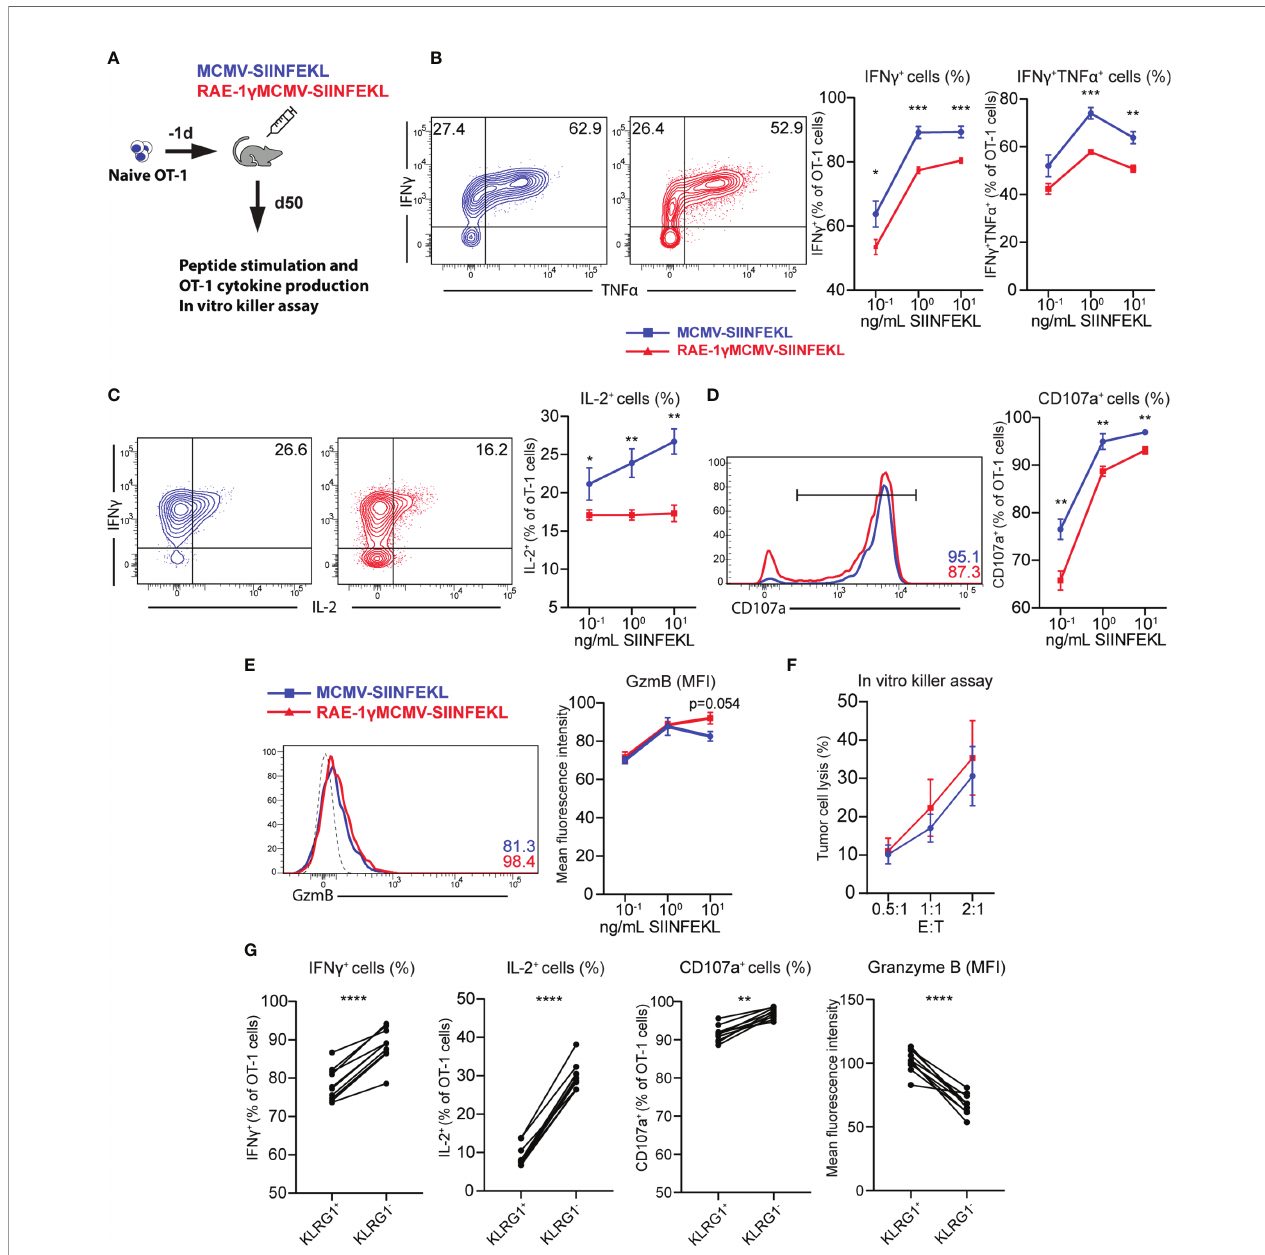
FIGURE 4 | CD8 T cells primed with RAE-1 g MCMV show lower cytokine-producing capabilities than cells primed with the virus lacking RAE-1 g but similar cytotoxic potential. (A) Naive OT-1 (CD45.1) cells were transferred to CD57BL/6J mice (CD45.2). One day after the transfer, mice were immunized with indicated viruses (n=5- 6). On day 50, mice were sacri fi ced, and splenocytes were stimulated with different concentrations of SIINFEKL peptide. Production of IFN- g and TNF- a (B) , IL-2 (C) , CD107a (D) , Granzyme B (E) was analyzed using fl ow cytometry. (F) Memory time point OT-1 cells were incubated with E.G7-OVA cells in indicated effector:target ratios. (G) Percentage or MFI of indicated molecules in KLRG1 + and KLRG1 - cells. Data are from a single experiment representative of two independent experiments. Data is represented as mean ± SEM and statistical signi fi cance *p < 0.05, **p < 0.01, ***p < 0,001, ****p<0,0001. Statistical signi fi cance was determined using unpaired Student